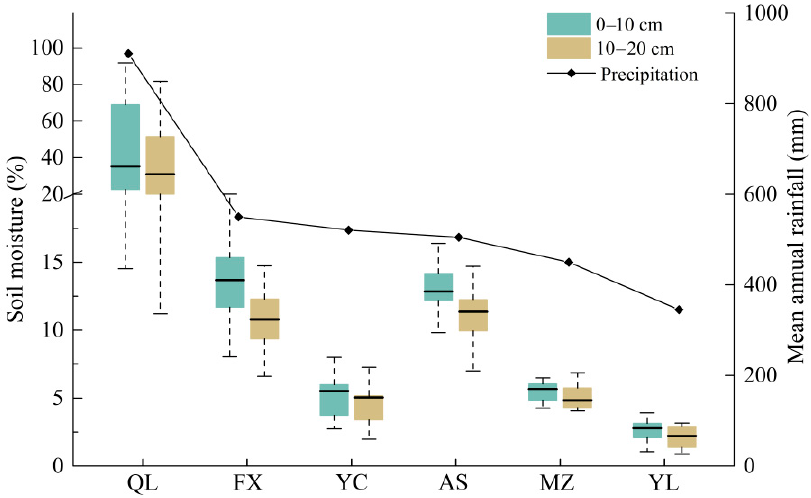
Figure 2. Mean annual rainfall and soil moisture content at different sites along the climatic gradient.